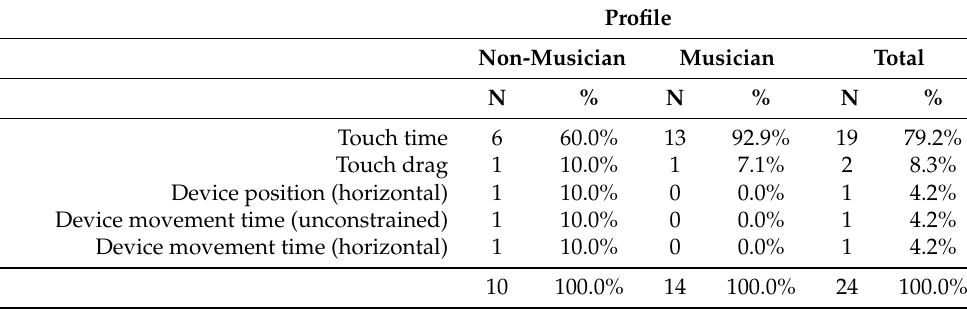
Table A11. Duration variation mapping (uncategorized)—stimulus